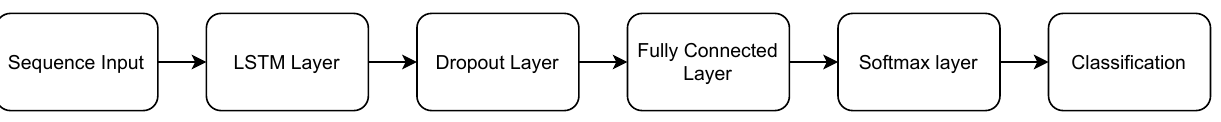
Figure 13. LSTM network architecture of Experiment 2.